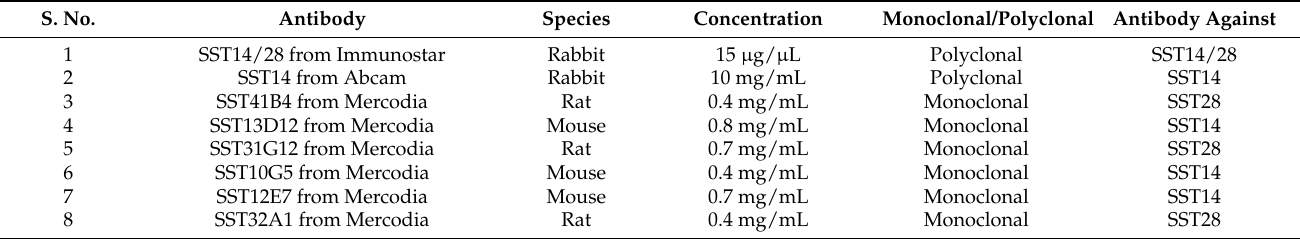
Table 1. Table documenting the details of the antibodies